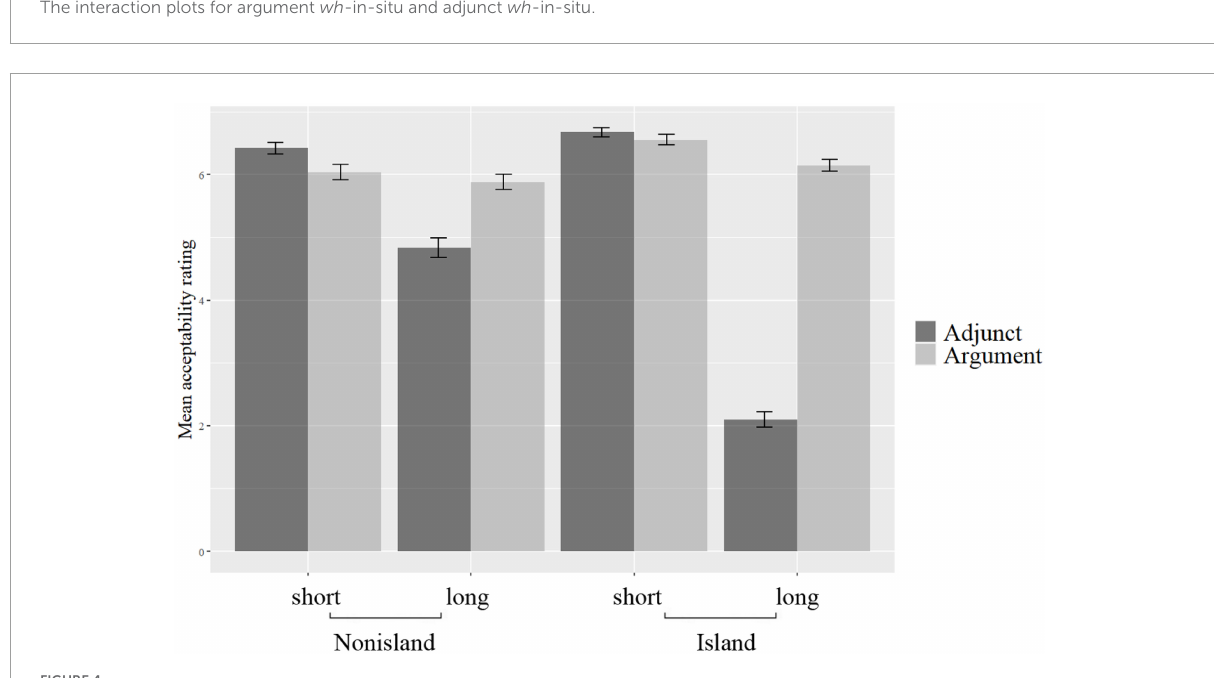
FIGURE4 Mean acceptability rating